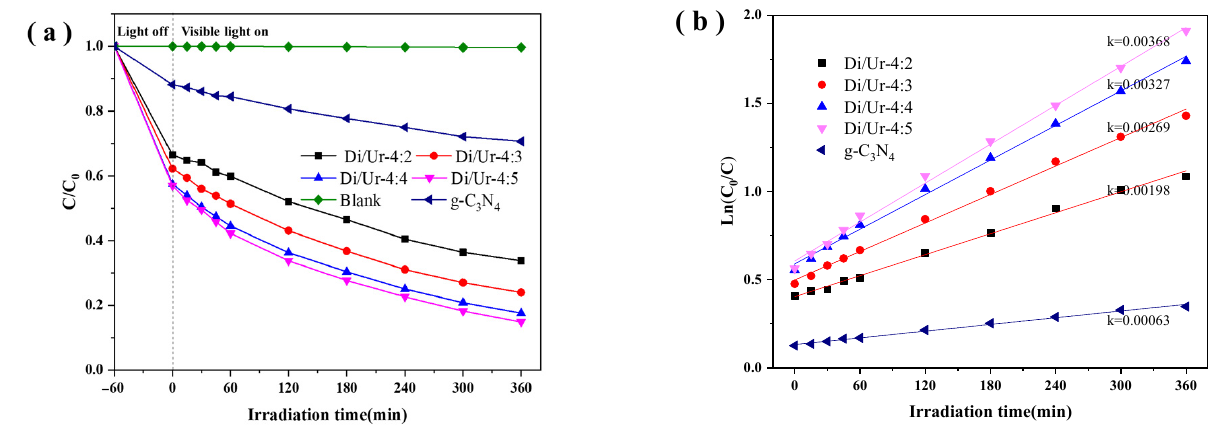
Figure 5. Photocatalytic degradation ( a ), and linear transform Ln(C 0 /C) of the kinetic curves ( b ), of RhB under visible light.